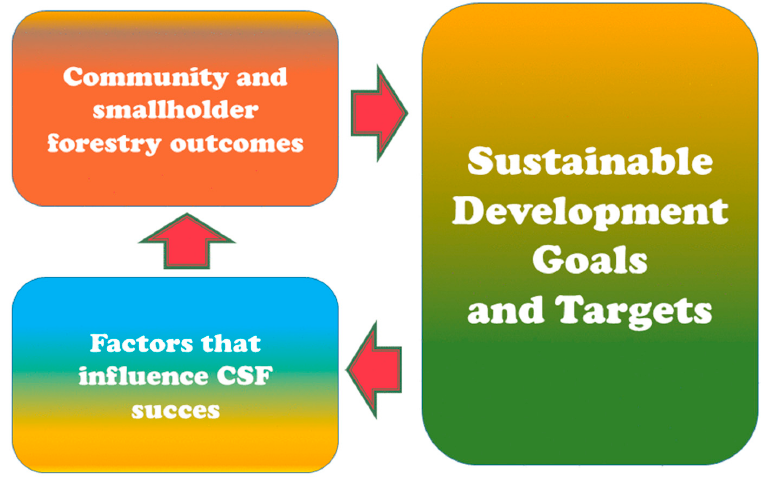
Figure 1. The CSF-SDG positive feedback model.